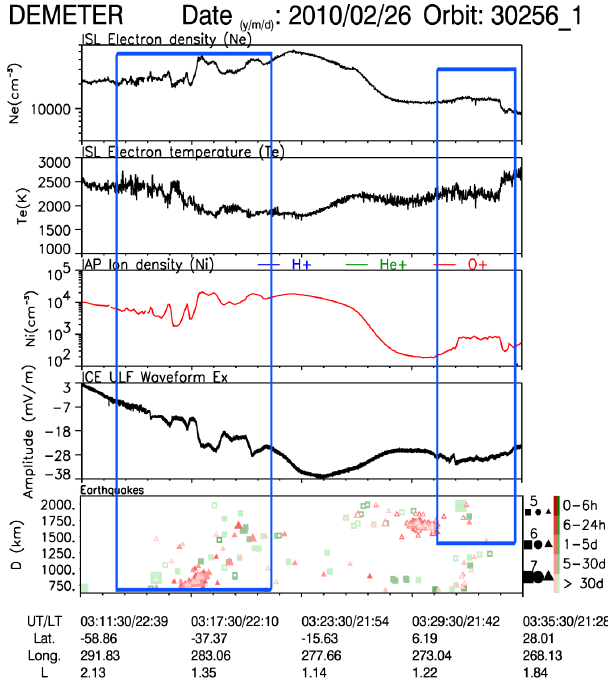
Figure 4. The observation of plasma parameters from DEMETER on 26 February 2010, 1 day before the Chile M8.8 earthquake on 27 February 2010 (the order of the five panels is the same as in Fig.